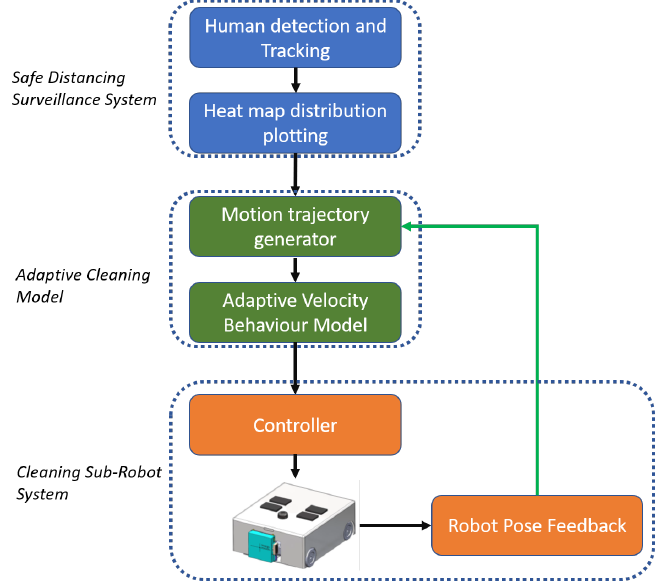
Figure 5. Motion planner framework for sub-robot cleaning